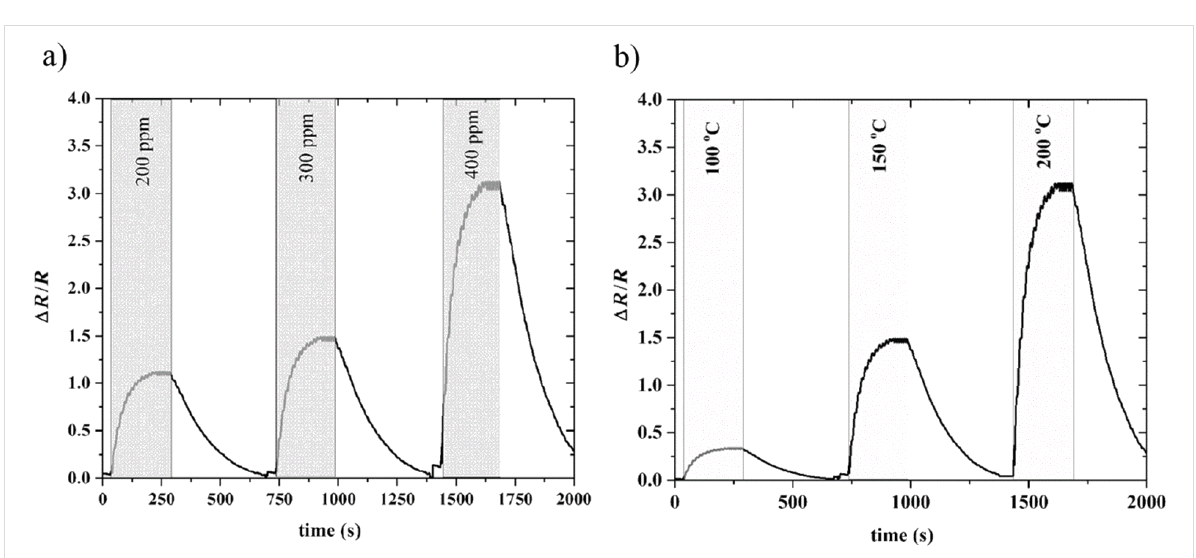
Figure 5: Typical response of MoS 2 nanoflakes toward xylene for: (a) different concentrations at 200 °C working temperature, (b) for 400 ppm at dif- ferent working